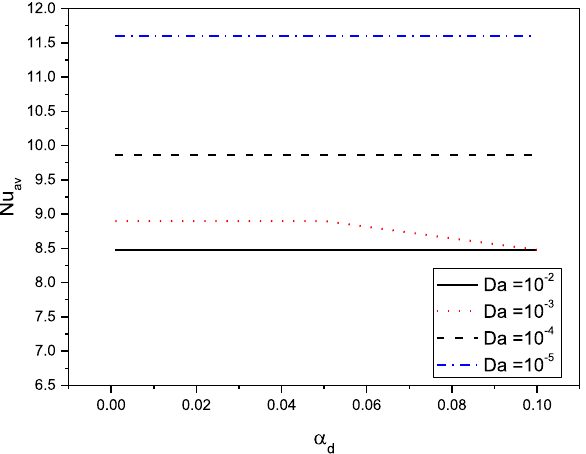
Figure 11. Profiles of the average Nusselt Number for the variations of α d and Da in case of 1.5 ) at Ra (η 1 η 2 η 3 = = =